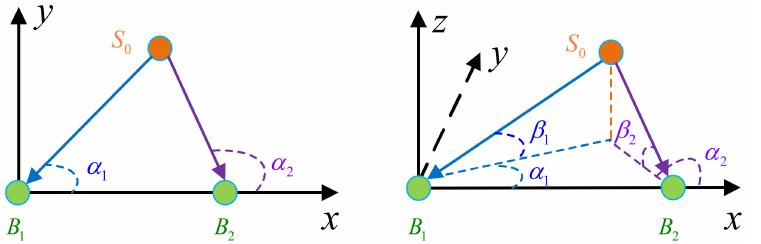
Figure 2. Schematic diagram of DOA-based positioning using two cooperative deciphers: ( left ) 2D positioning using 1D-DOA estimation; ( right ) 3D positioning using 2D-DOA estimation.